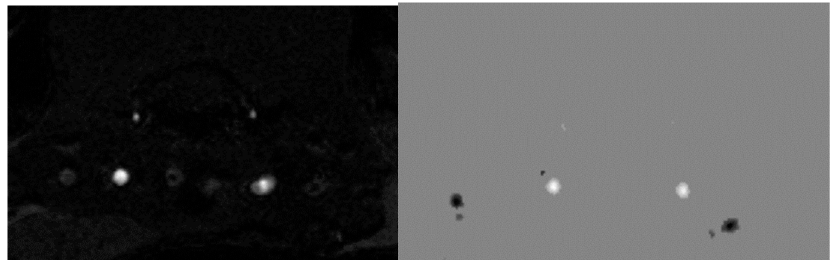
Figure 15. ( Left ) 2D TOF image of carotid arteries; ( right ) 2D image of the same area obtained using PCA.